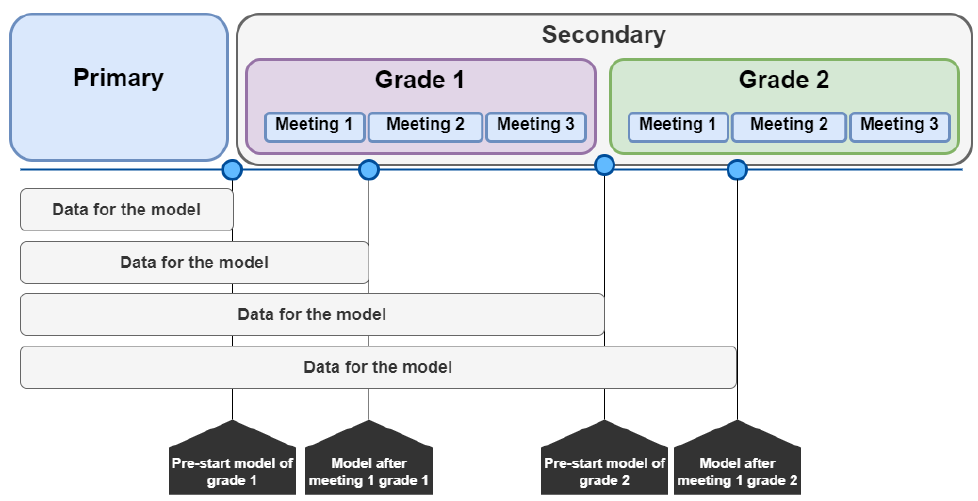
Figure 4. Temporal approach for the models and retraining periods.